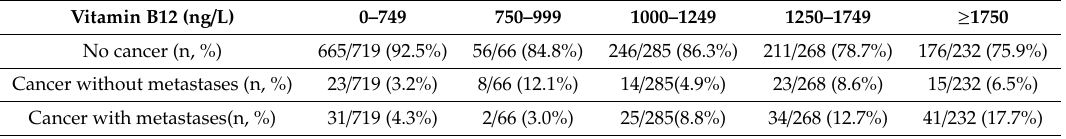
Table 3. Solid cancers frequency according to vitamin B12 interval and to the presence of metastases. Vitamin B12 (ng / L) No cancer (n, %) Cancer without metastases (n, %) 23 / 719 (3.2%) Cancer with metastases(n, %)